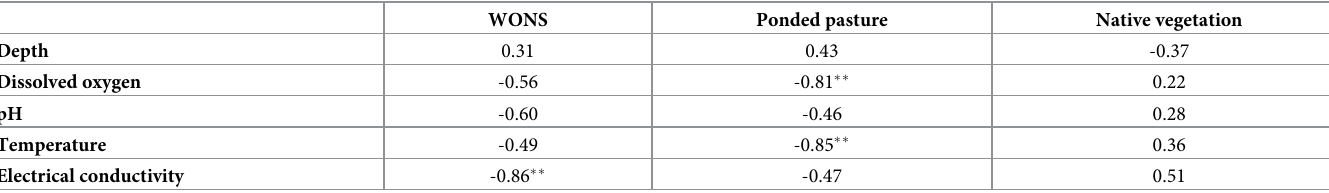
Table 3. Linear correlation between water quality measures and vegetation proportion.